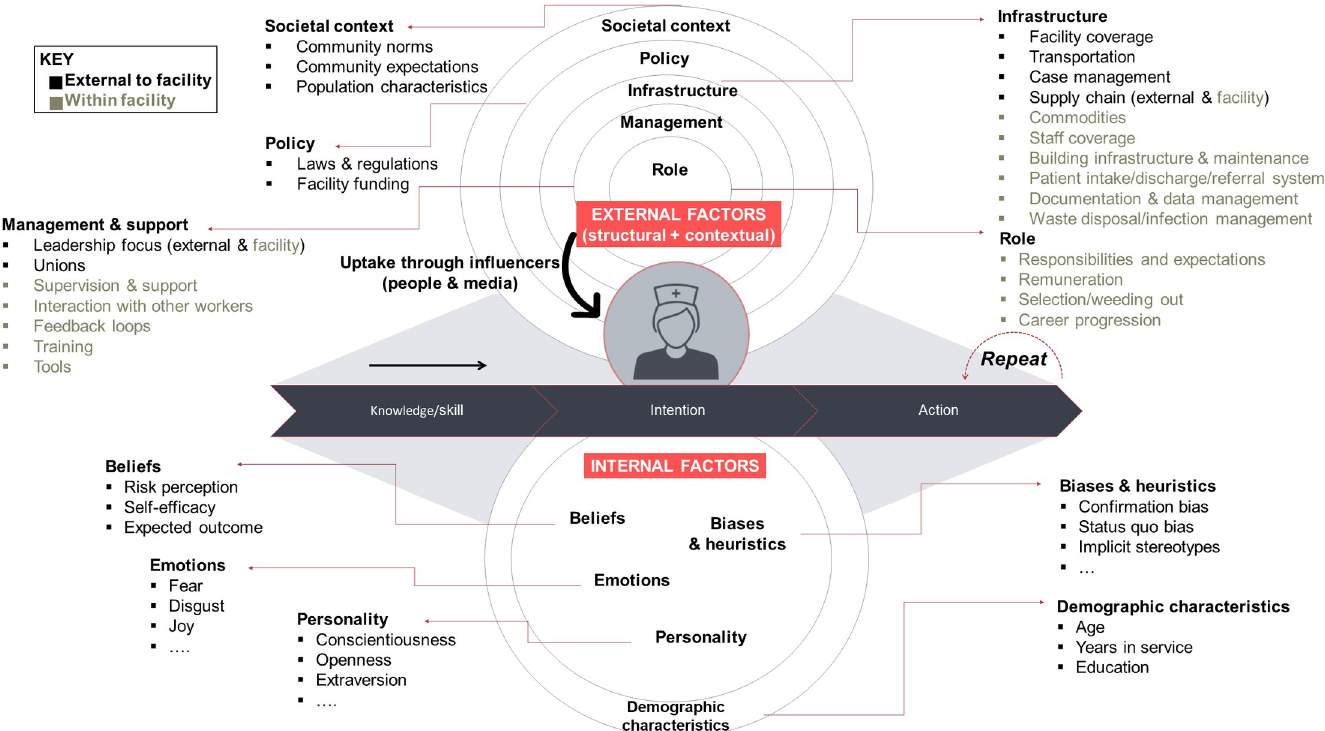
Fig 1. Framework for Unpacking Provider Practices (UPP). The framework outlines the complex set of factors influencing facility outcomes via the clinical practices of staff.